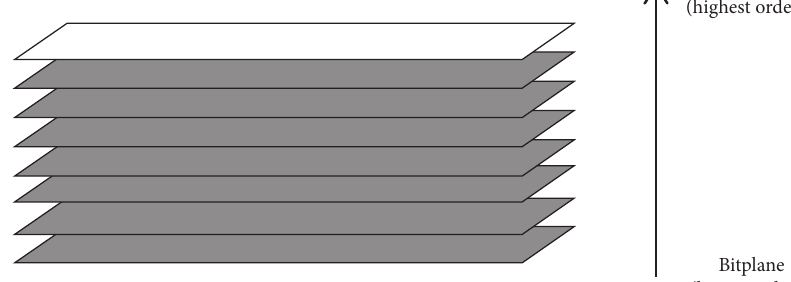
Figure 8: Bit plane representation of an 8-bit